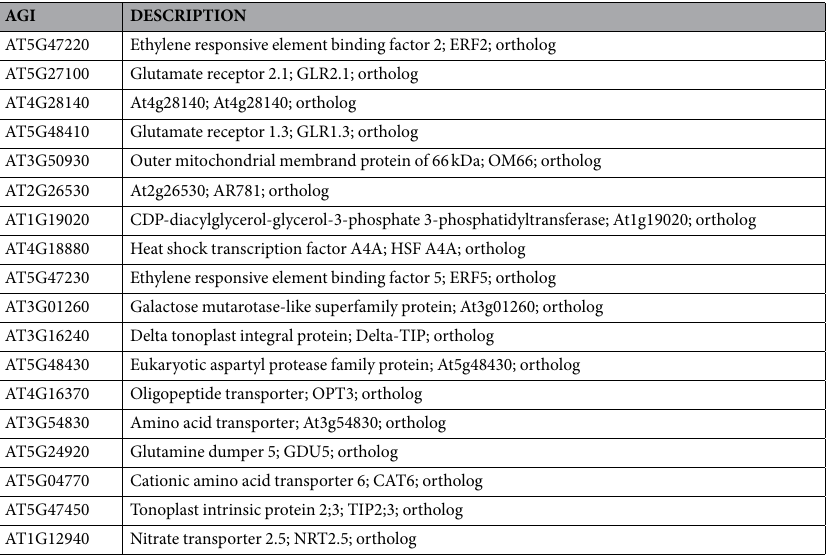
Table 3. Genes enriched in nitrogen compound response and transport clusters regulated by NLP7